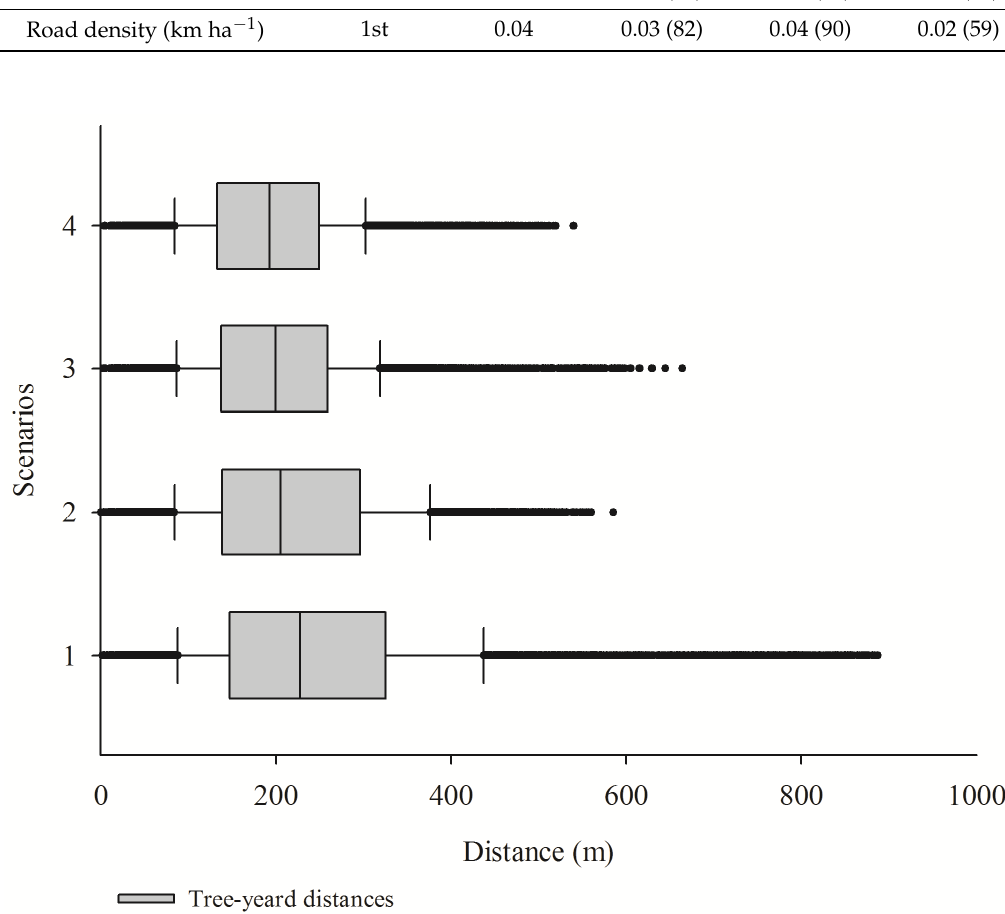
Figure 8. Dispersion of tree-yards’ distances for each scenario.